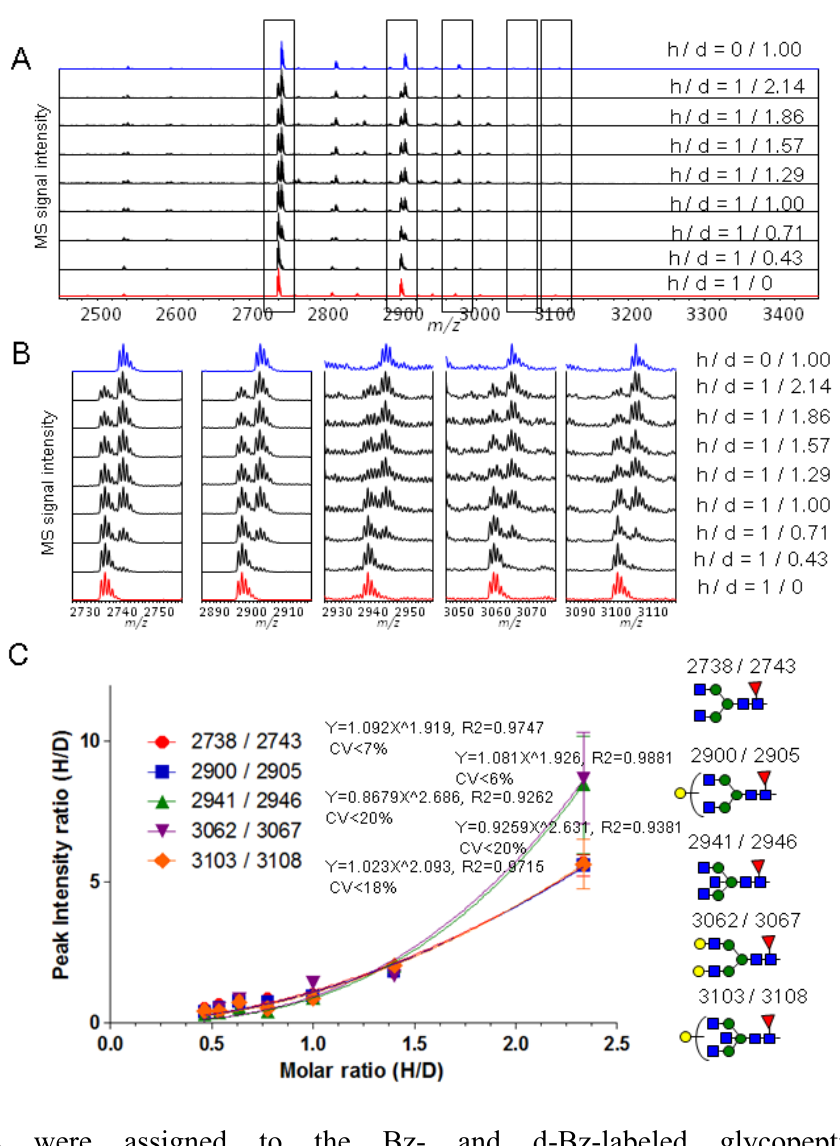
HexNAc dHex , Hex HexNAc dHex 3 4 1 4 4 1